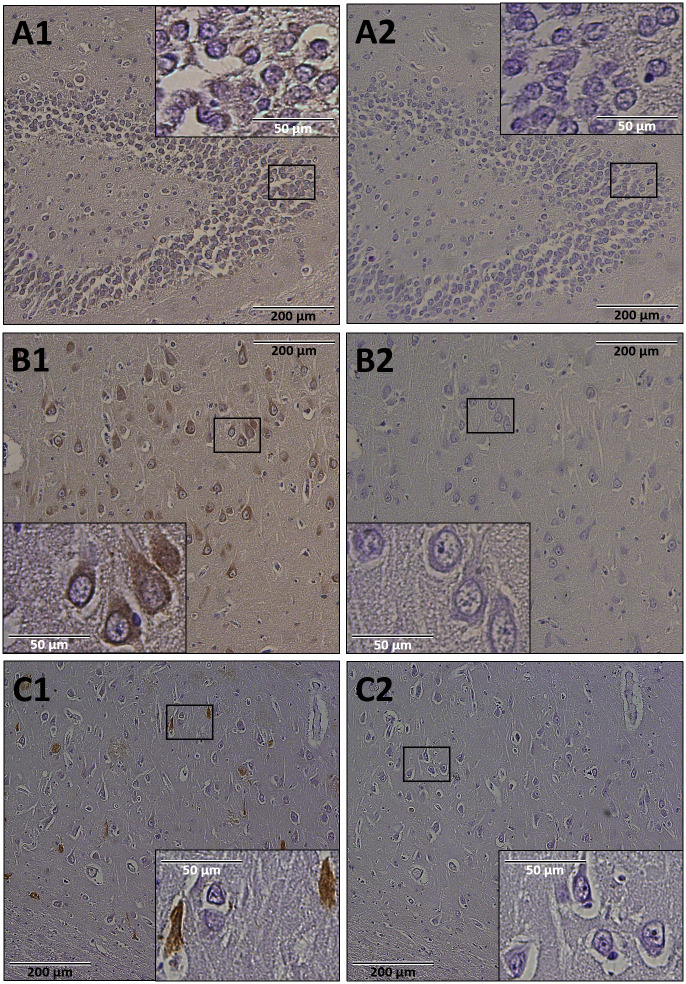
Spatial localization of brevican in human hippocampal AD brain tissue.Shown are two different locations in human hippocampal AD brain tissue incubated with anti-N-Brev antibodies (A1, B1); anti-N-Brev antibodies pre-incubated over night with N-Brev selection peptides in a ratio of 1:50 moles (A2, B2) and commercial anti-brevican antibodies (C1) with a blank control (C2). The extracellular matrix and the cytoplasm of neurons are stained. (n = 1).